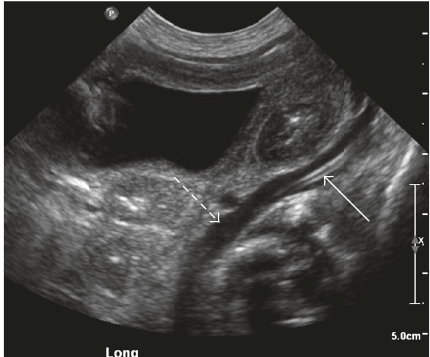
Figure 3: Sonographic imaging demonstrating the umbilical catheter (solid arrow) within the left iliac vein (dashed arrow) in close proximity to the